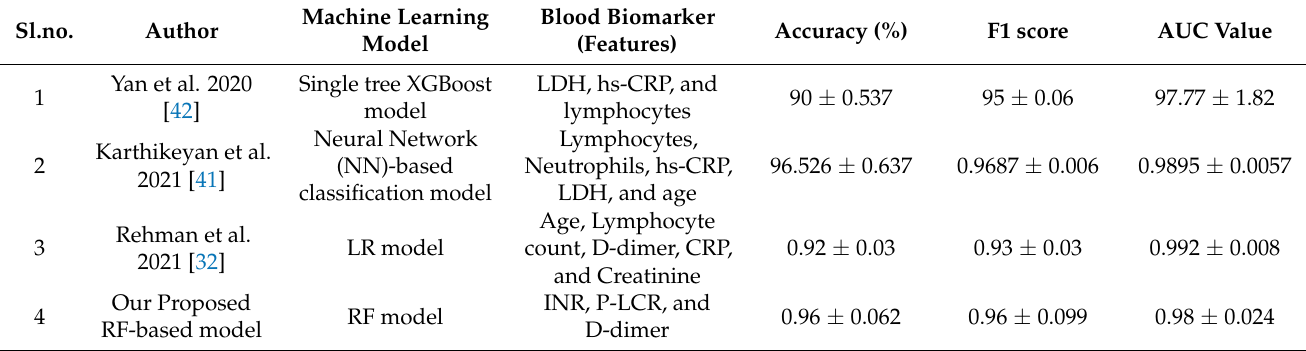
Table 6. Comparative performance evaluation between models built using the same test